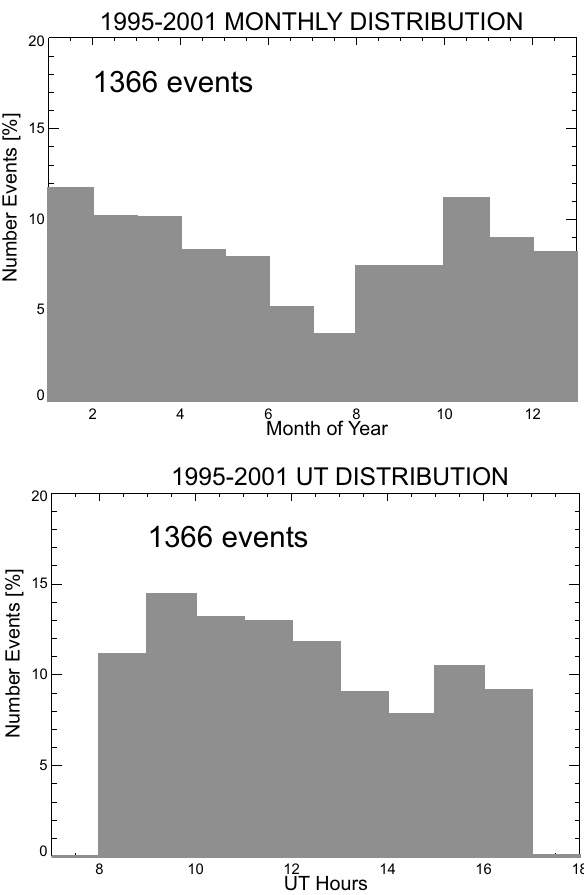
Fig. 6. The upper panel displays the monthly occurrence rates and the lower panel the diurnal distribution of the subgroup of events observed with an amplitude of at least 30 nT at the station SKT. The number of events is shown in each